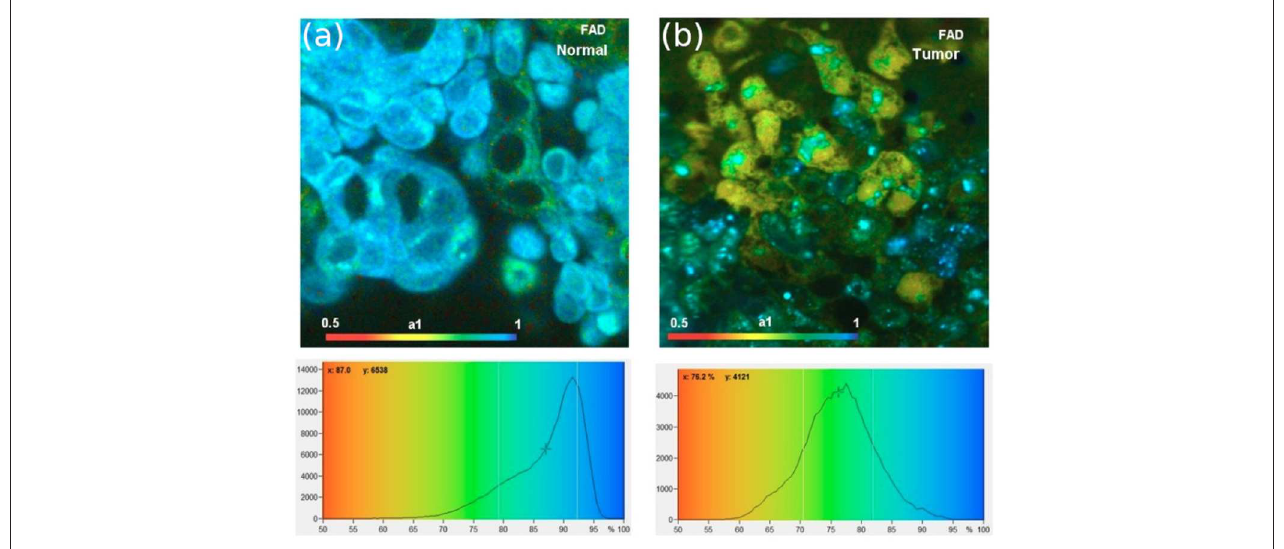
FIGURE 11 | Applications of fast scanning FLIM. (a,b) Metabolic state monitoring of cells with fast scanning FLIM. The images show the bound fraction of FAD, which decreases for cancer cells. Reproduced from Becker et al. [183].